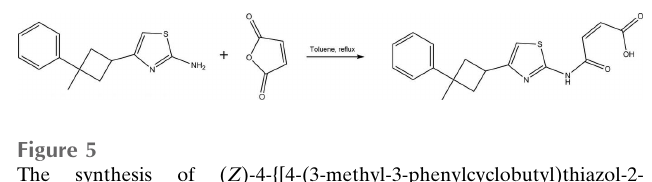
Figure 5 The synthesis of ( Z )-4-{[4-(3-methyl-3-phenylcyclobutyl)thiazol-2- yl]amino}-4-oxobut-2-enoic acid.